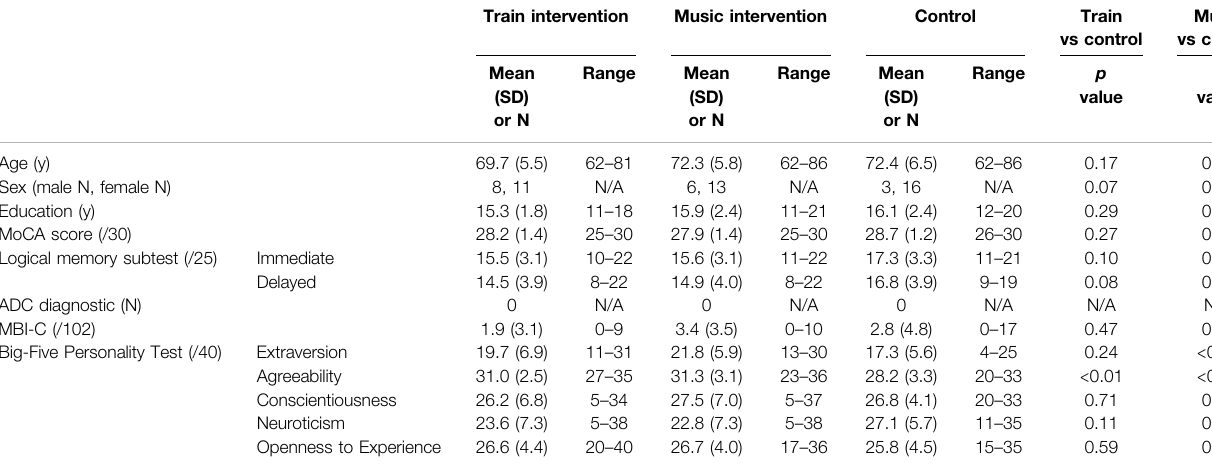
TABLE 1 | Participants ’ demographic and clinical characteristics.